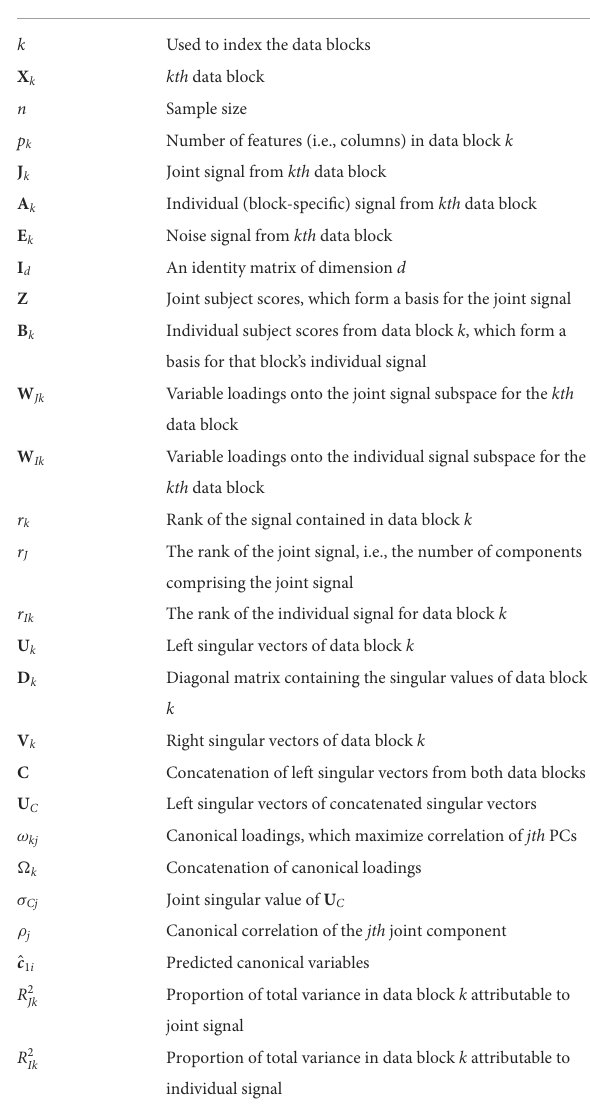
TABLE 1 Notation used throughout the